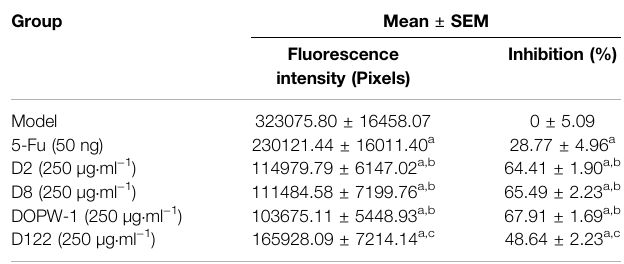
TABLE 2 | Effects of D . of fi cinale polysaccharides of different Mw on a zebra fi sh xenograft model.